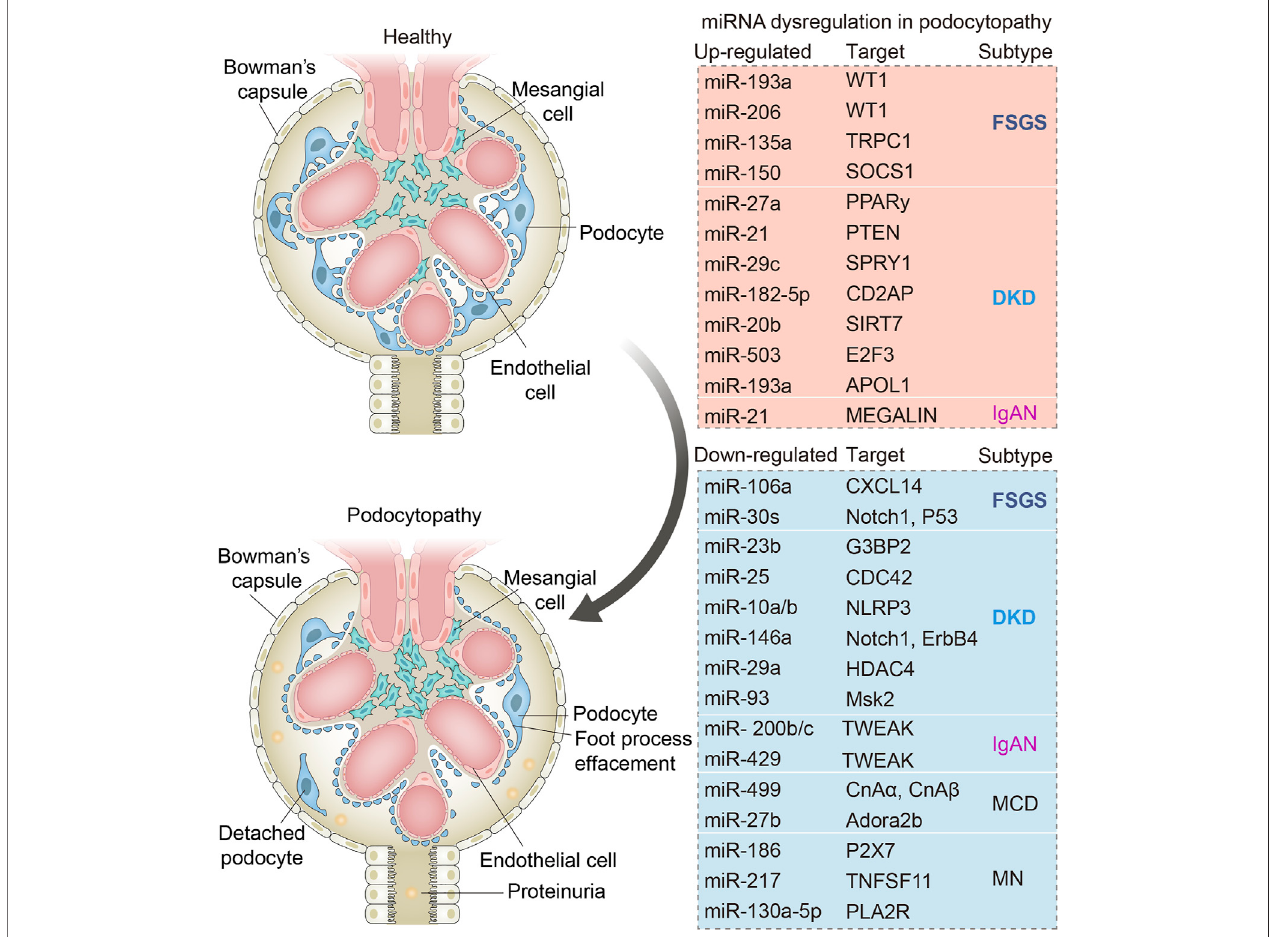
FIGURE 2 | Schematic diagram showing the main dysregulated miRNAs and their corresponding downstream targets in various podocytopathies. Changes in miRNAs in podocytes occurring in focal segmental glomerulosclerosis (FSGS), minimal change disease (MCD), membranous nephropathy (MN), diabetic kidney diseases (DKD), and IgA nephropathy (IgAN). Dysregulation of indicated miRNAs contributes to podocyte injuries including podocyte foot process effacement and podocyte loss due to cell death or detachment from the glomerular basement membrane.